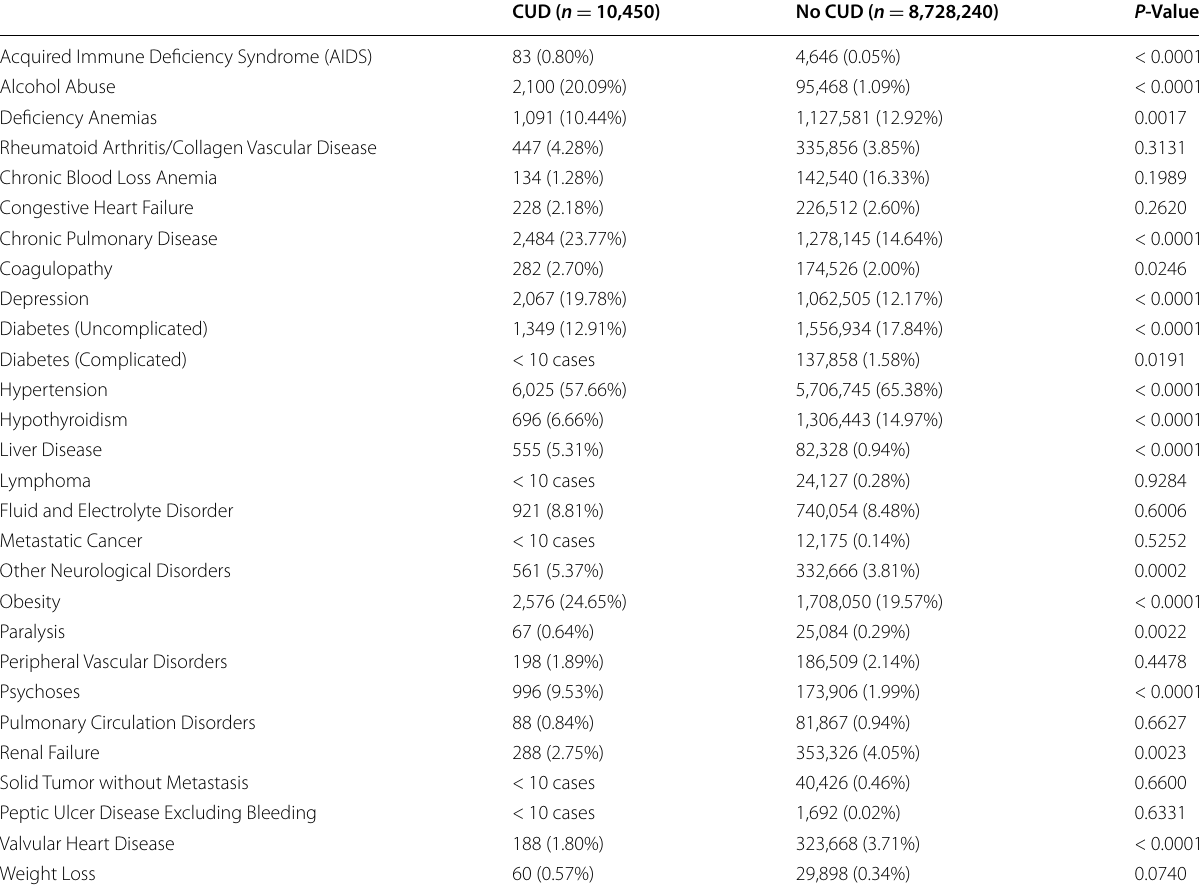
Table 3 Elixhauser comorbidities stratified by CUD vs . no CUD